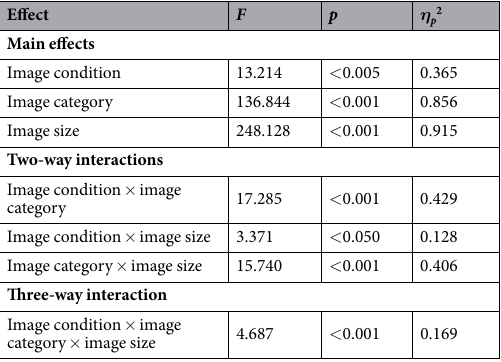
Table 6. Results of the 2 × 3 × 5 (image condition × image category × image size) ANOVA for the number of